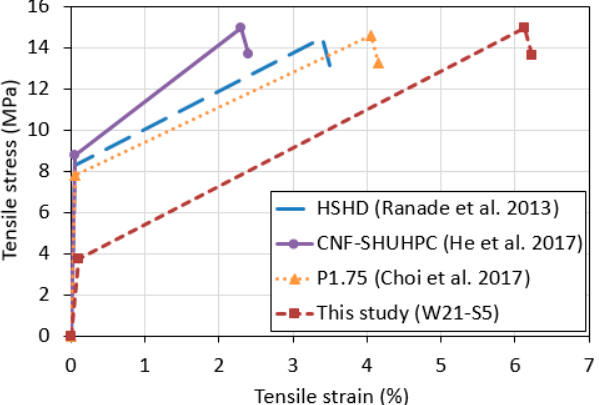
Figure 8. Comparison of tensile stress and strain curves of ultra-high performance concretes with high-ductility and the W21-S5 mixture. Table 3. Comparison of performance of ultra-high performance concretes with high-ductility and the W21-S5 mixture.